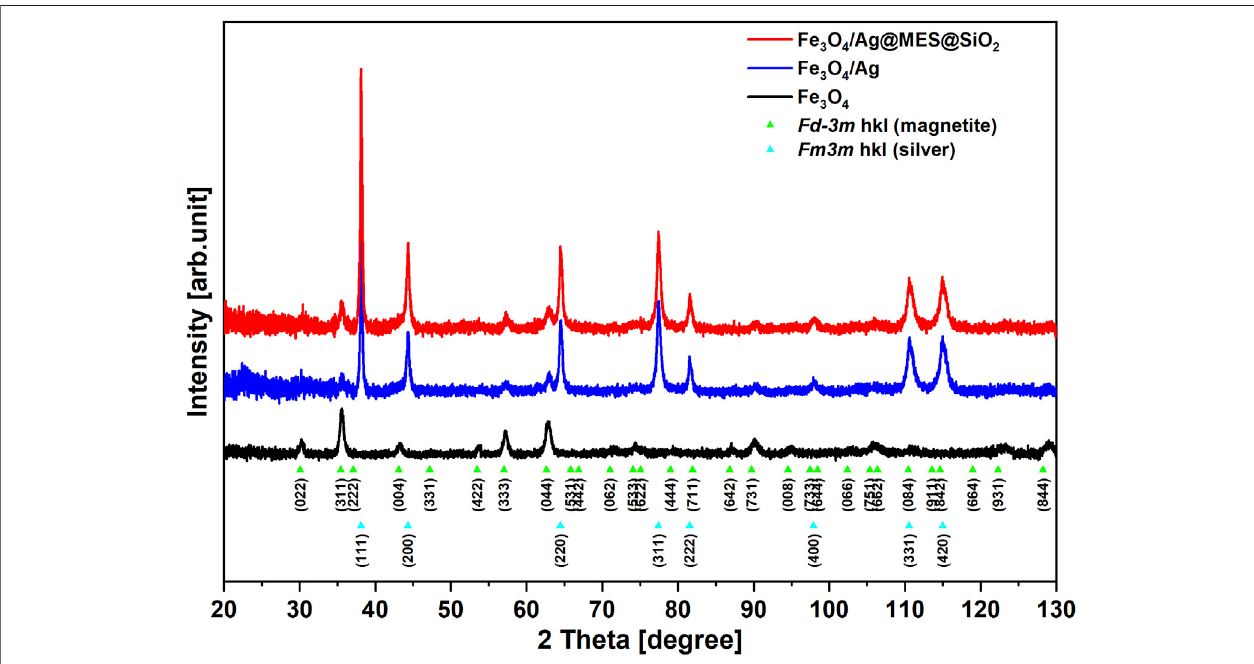
− 3m magnetiteand Fm3m silvergroups.